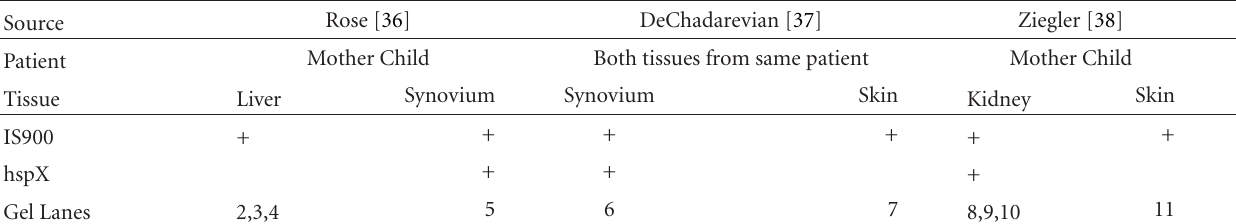
Table 1: Results of DNA probing for IS900 and hpsX of Mycobacterium avium ss. paratuberculosis (MAP) in Blau Syndrome